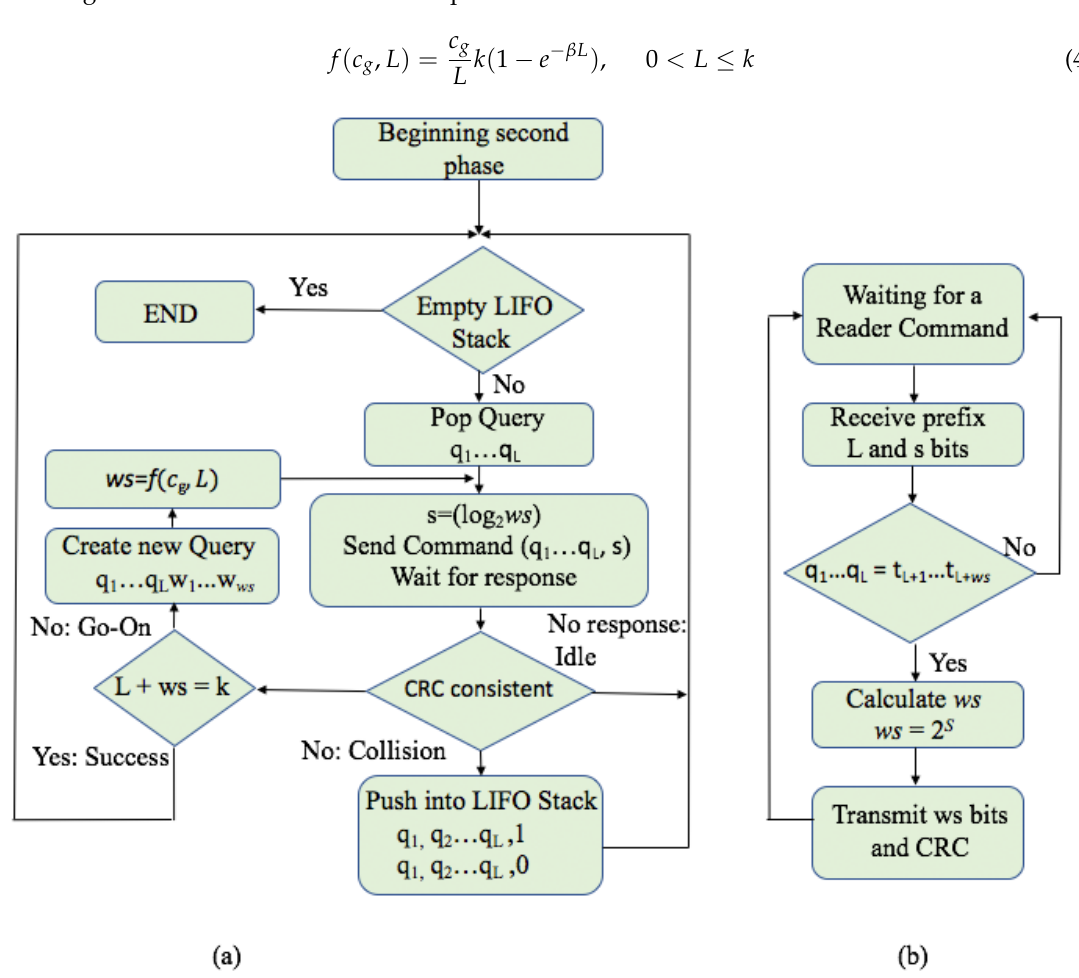
Figure 10. Flow chart of the proposed FQwT protocol: ( a ) for reader; ( b ) for